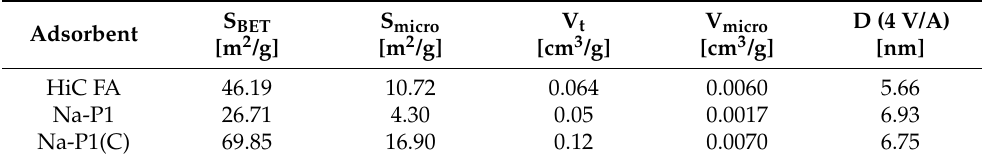
Table 3. Textural parameters of HiC FA, Na-P1 and Na-P1(C) adsorbents.